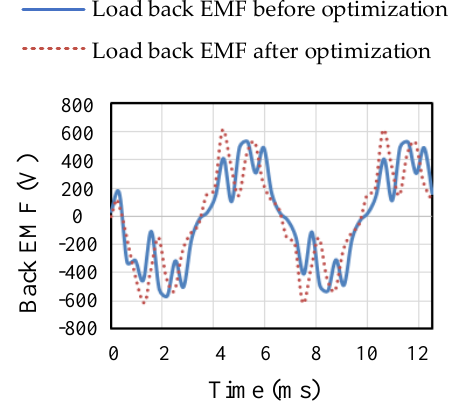
Figure 11. Back EMF of the AFPMSM at the peak load.